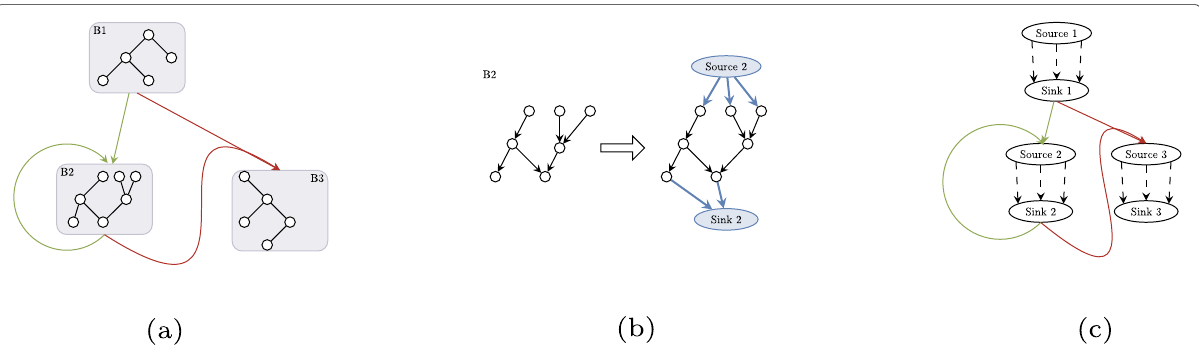
Fig. 1 This figure illustrates how the program graph is constructed from the CFG on a toy example with three basic blocks. Figure ( a ) demonstrates, that for each basic block independently we construct a computational tree. On fig ( b ) we can see, that each tree is completed with two nodes - a source and a sink, this way turning it into a directed acyclic graph (DAG). On fig ( c ) we demonstrate how all DAGs are connected following the same topology as CFG had initially